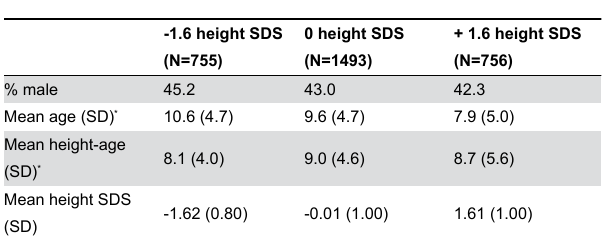
Table 1. Subject characteristics by height distribution.